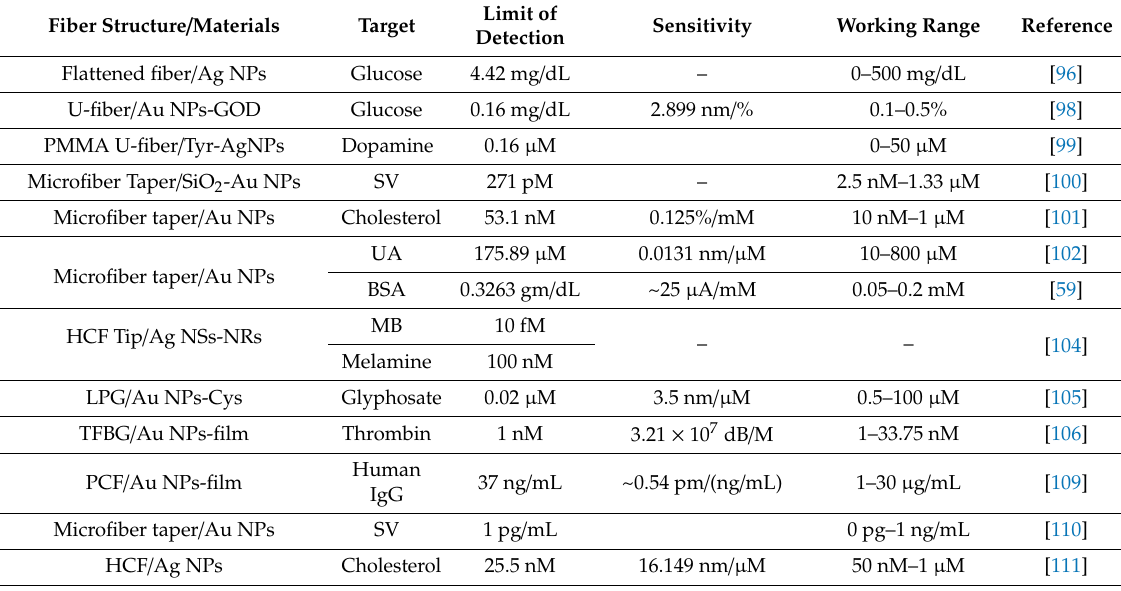
Table 3. Performance comparison of LSPR biosensors based on di ff erent structures and